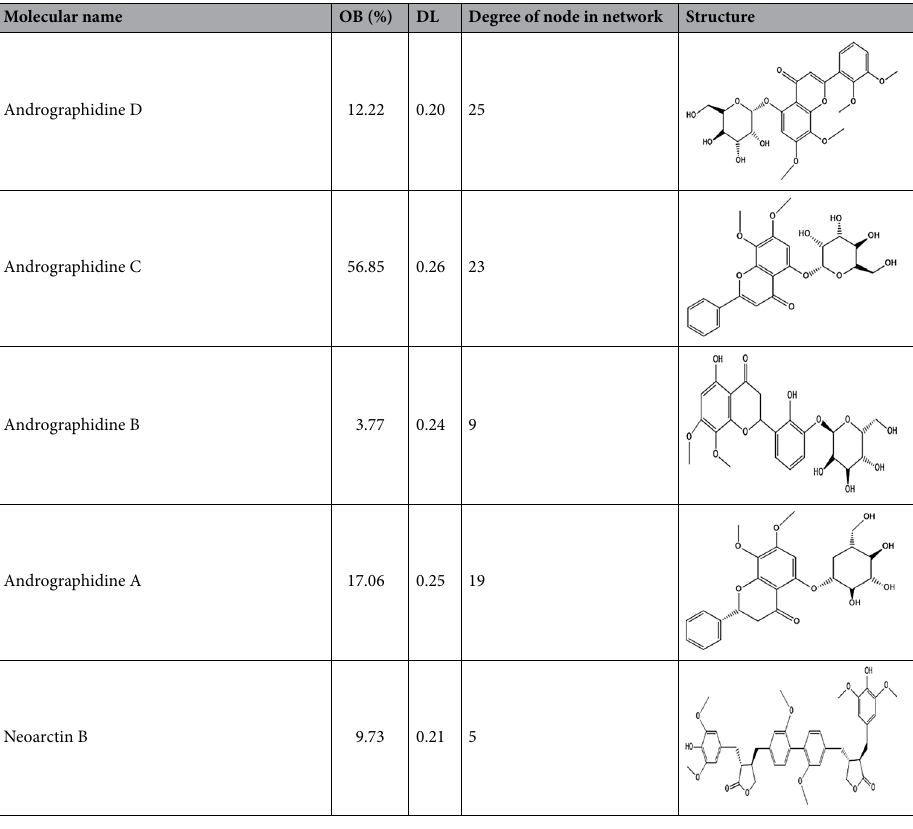
Table 1. Information of bioactive compounds of Chuan Xinlian.